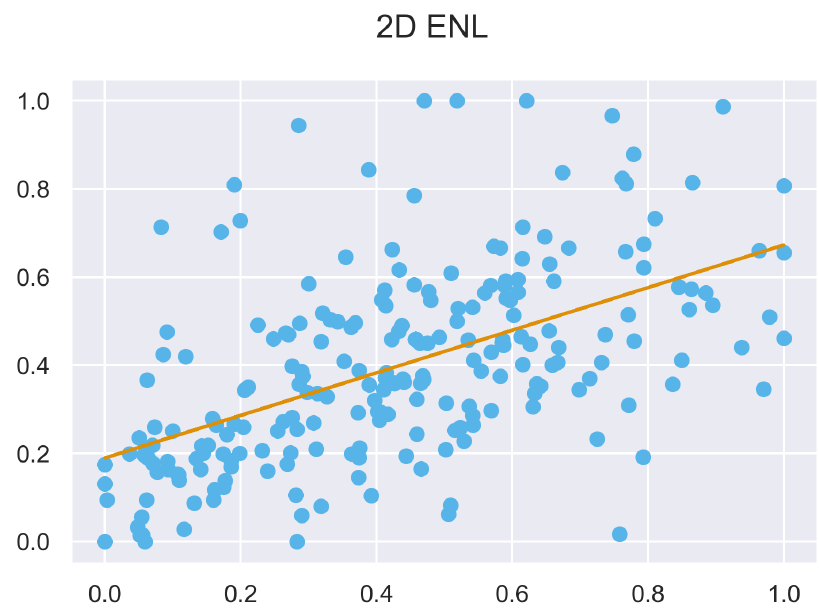
Figure A44. ULS and TLS 2 D ENL regression at 5m grid